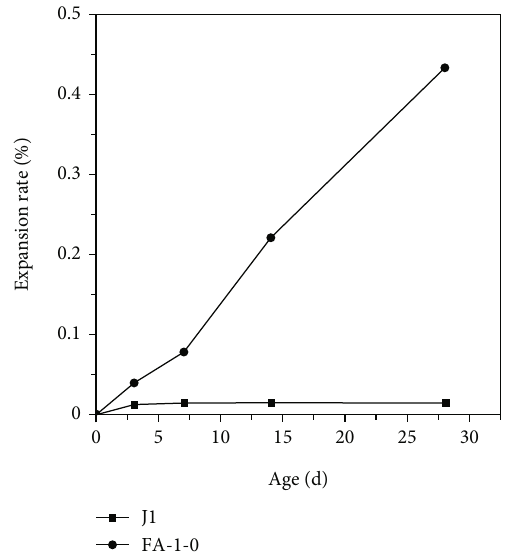
Figure 4: The diagram between FA-1-0 benchmark specimen and